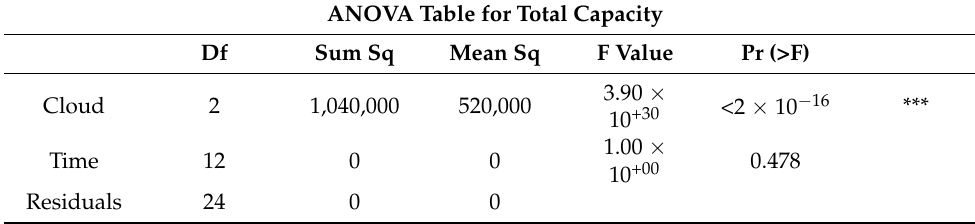
Table 1. ANOVA Table for Total Capacity.